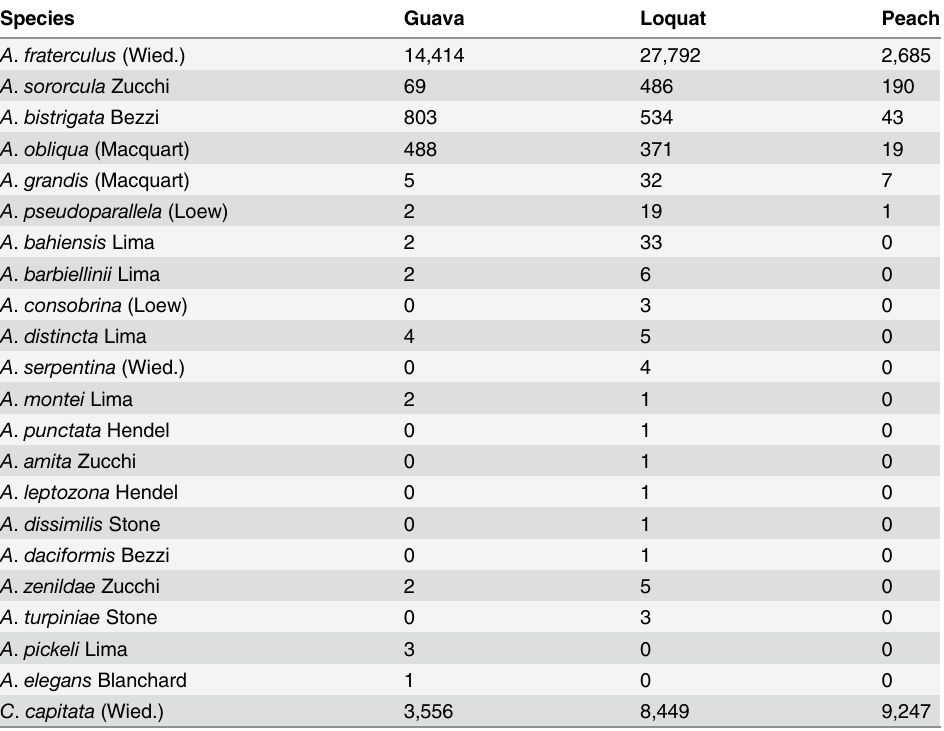
Table 1. Total females abundance of native tephritid Anastrepha species and the introduced Mediter- ranean fruit fly Ceratitis capitata collected in three fruit orchards, Monte Alegre do Sul, S ã o Paulo, Brazil (2002 – 2003). Species Guava Loquat Peach A . fraterculus (Wied.) 14,414 27,792 2,685 69 486 190 803 534 43 488 371 19